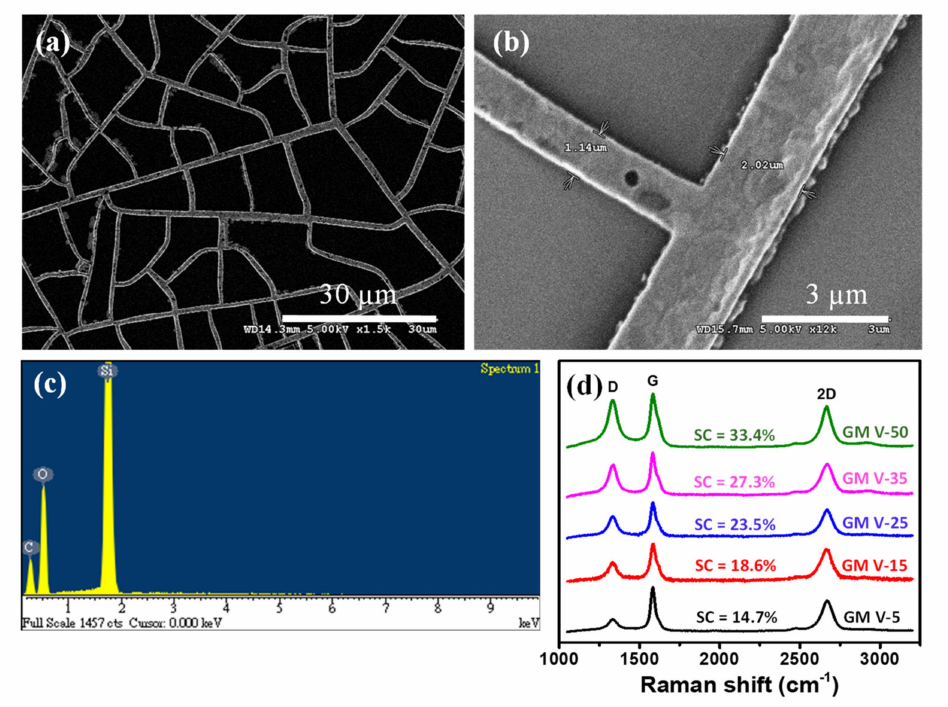
Figure 2. ( a , b ) The scanning electron microscope (SEM) image of the GM V-50 sample on a SiO 2 /Si substrate; ( c ) EDS analysis of the GM V-50 on a SiO 2 /Si substrate; ( d ) Raman spectra of GM samples with different SCs of GM.